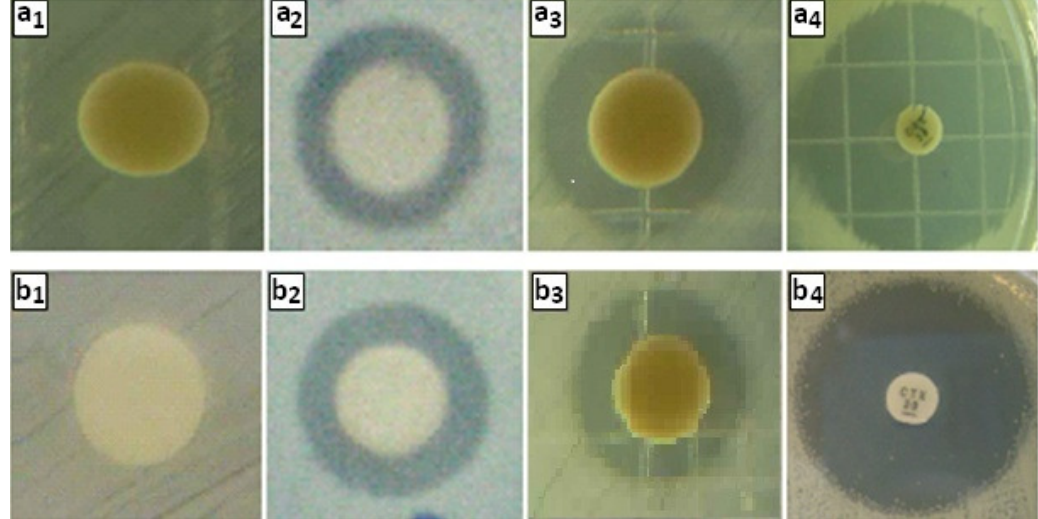
, b ) Cefotaxime (30 4 4